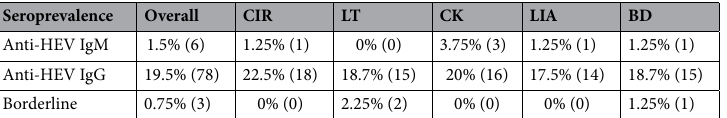
Table 2. Seroloprevalence data of Anti-HEV. WANTAI HEV IgG and HEV IgM ELISA. CIR cirrhotic patients, LT liver transplant patients, CK crack users, LIA residents in a low income area, BD blood donors, BD blood